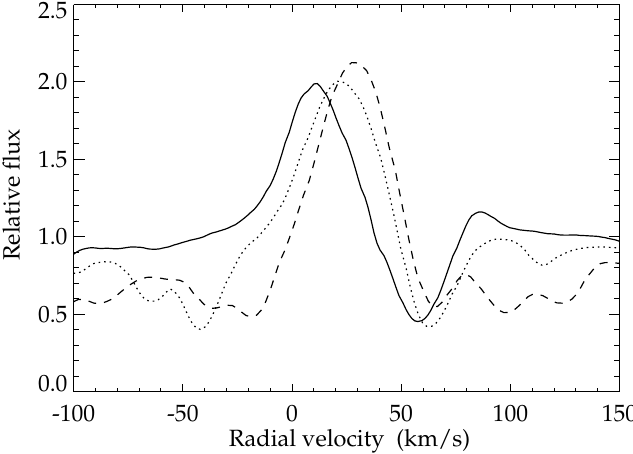
Fig. 7. The H α (solid line), H β (dotted line) and H γ (dashed line) lines in the spectrum of R Sct from the NARVAL database obtained on JD = 2454621.6. The complicated profiles of weak metallic lines of low excitation (Fe I, Ti I,